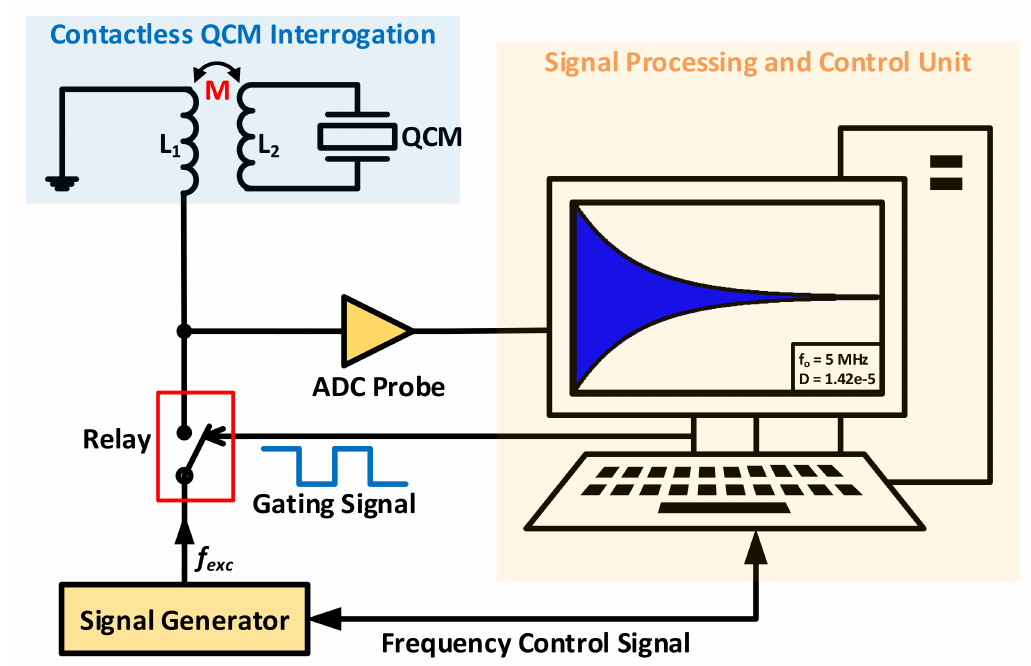
Figure 22. Contactless QCM-D based characterization system from